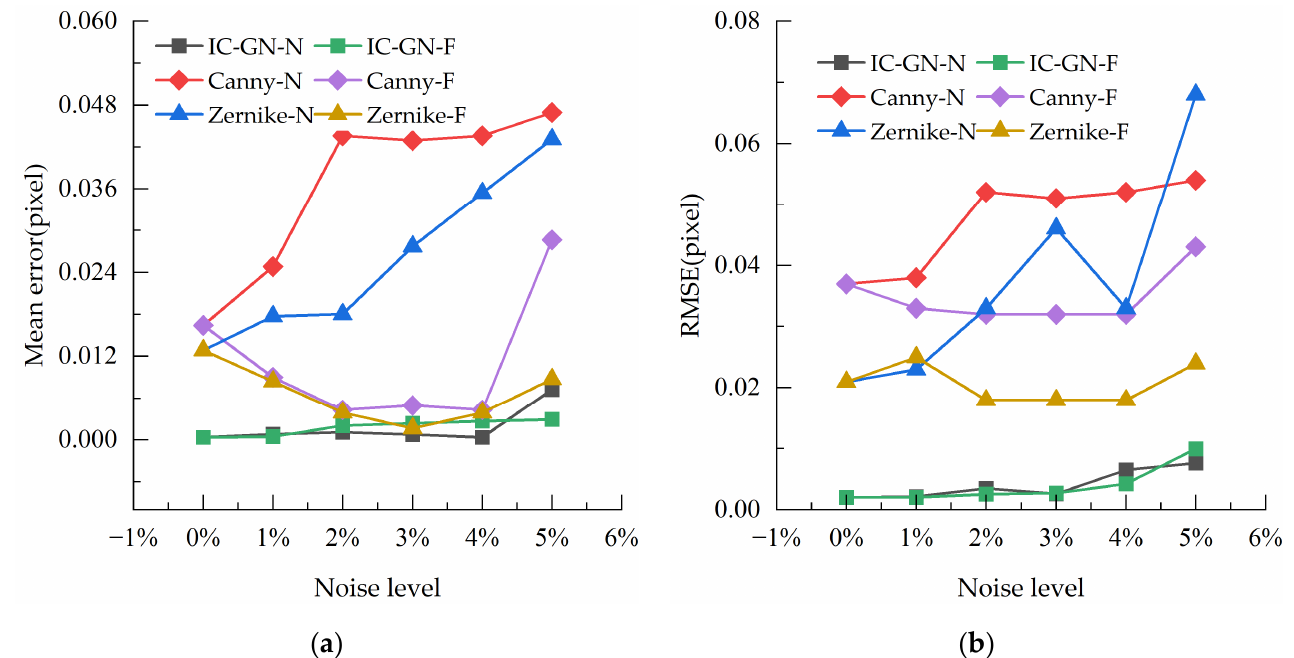
Figure 6. Performance evaluation of three algorithms (where N is before filtering and F is after filtering): ( a ) error variance; and ( b ) root mean square error.